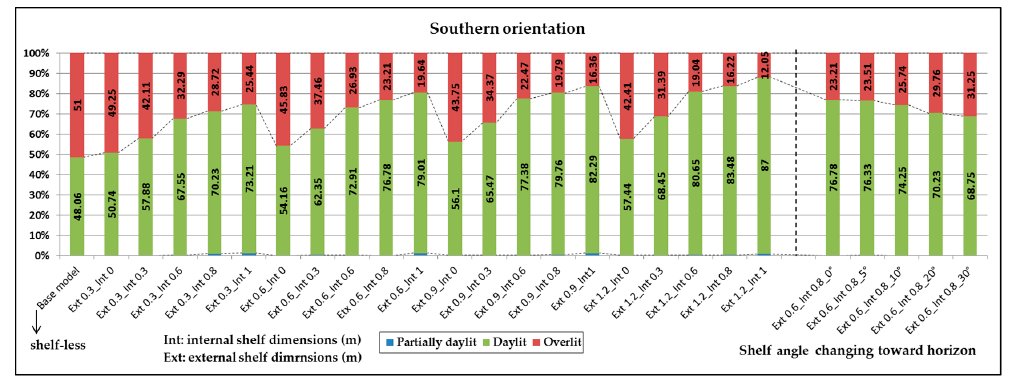
Figure 3. The results of daylight availability analysis for the southern orientation of the light shelf in the three mentioned intervals.